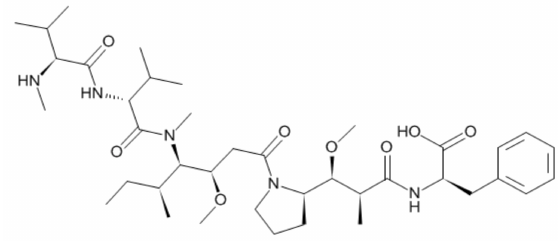
Figure 1. Structure of monomethyl auristatin F